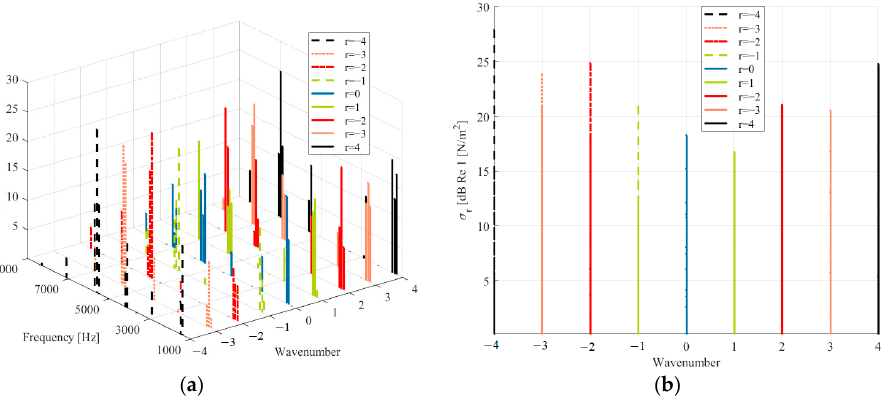
Figure 13. Space-time spectrum of electromagnetic force wave of the motor under 30% static eccen- tricity conditions: ( a ) space-time spectrum; ( b ) order–magnitude correspondence.